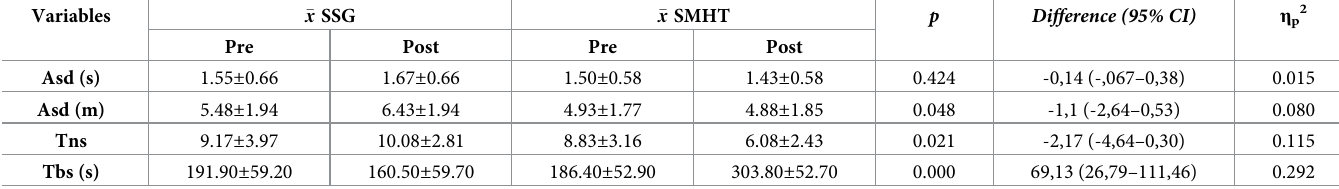
Table 4. Effect of SSG and SMHT training methods on game motion characteristics of higher speed running ( > 5.21 m � s -1 ) of the participants.